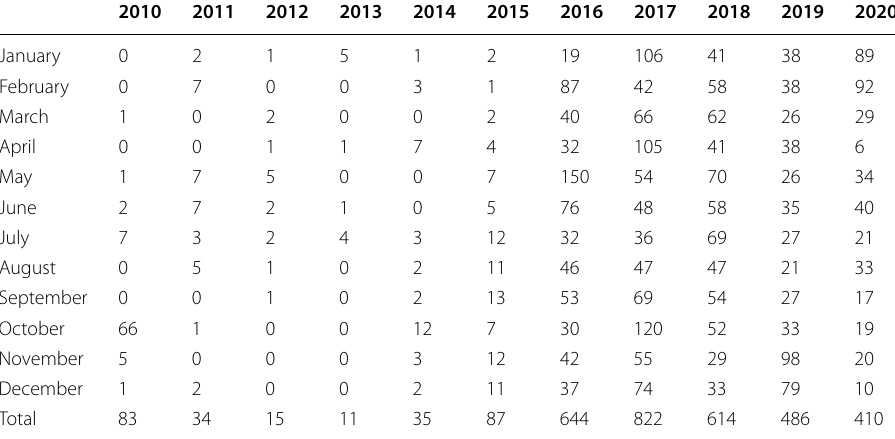
Table 11 Monthly and annual tweets over the years